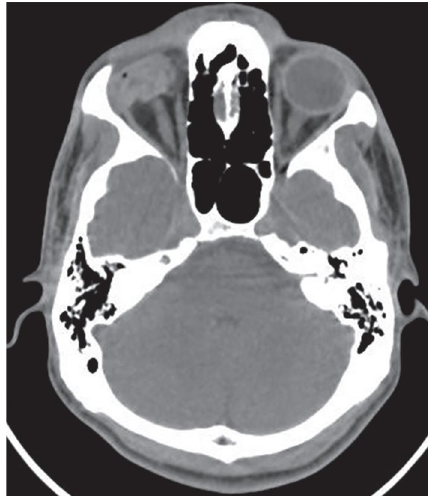
Figure 2: Open globe injury in a 26-year-old man. Axial unenhanced CT image showing right disorganized